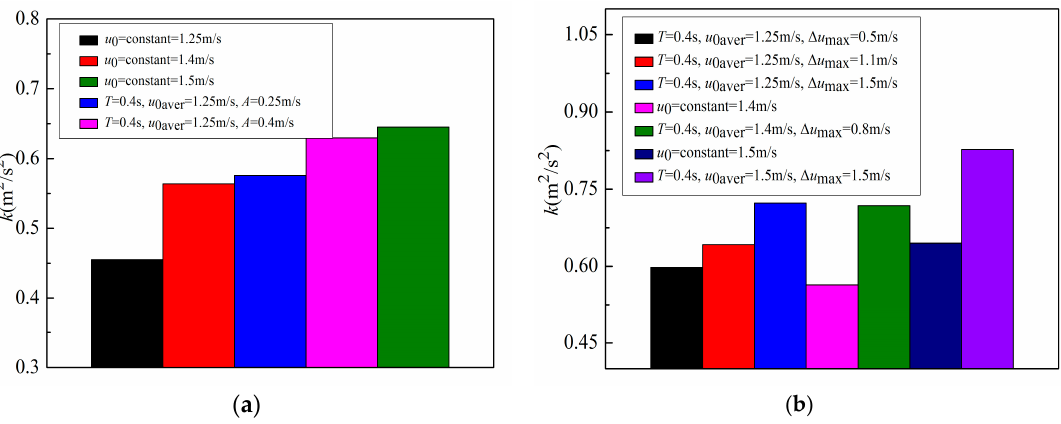
Figure 20. Effects of mean inlet velocity and the maximum ∆ u on the mean k of the impingement region during one period at T = 0.4 s, L/D = 4 and ∆ ϕ = T /2. ( a ) sinusoidal and constant inlet velocities; ( b ) step and constant inlet velocities.